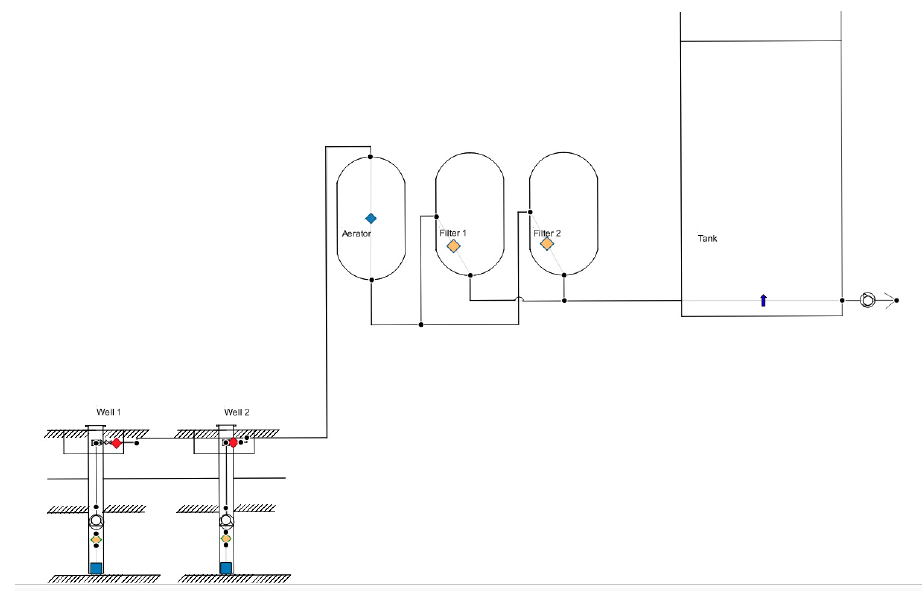
Figure 13. Analysed water treatment plant.